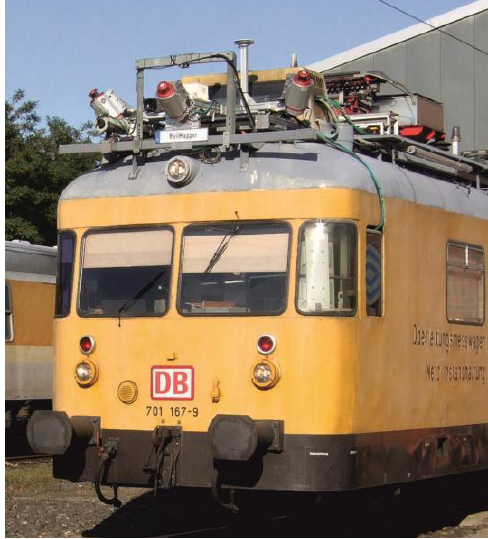
Figure 8: RailMapper sensor assembly with three laser